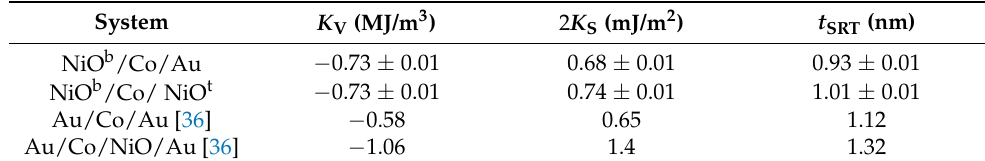
Table 2. Volume and surface anisotropy constants ( K V , K S ) and t Co at SRT thickness ( t SRT ) for